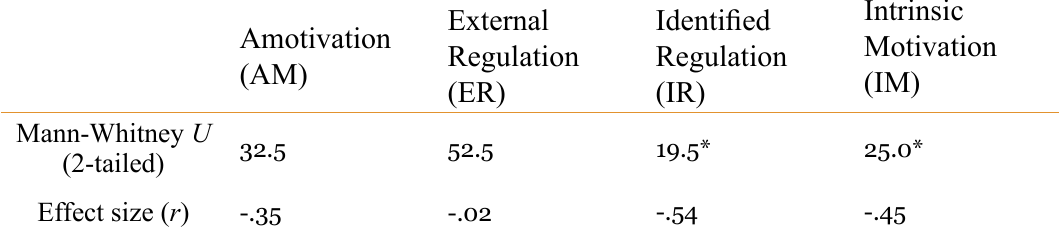
Table 3 Mann-Whitney U Results Comparing SIMS Subscale Scores across the